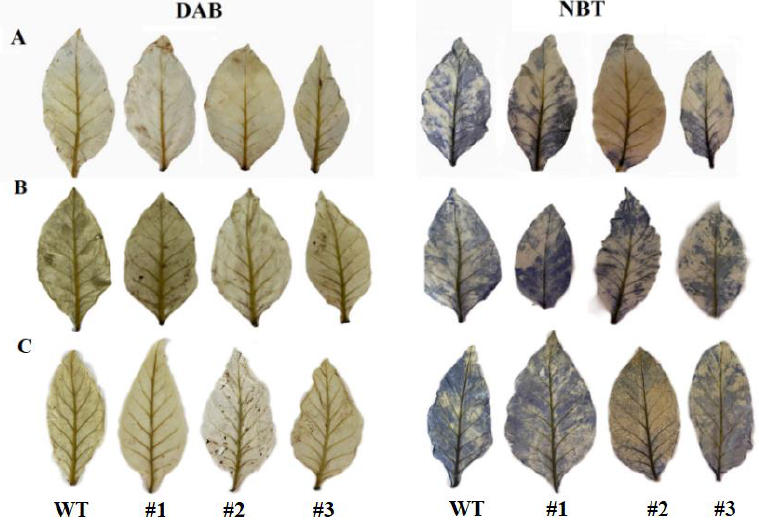
Figure 9. DAB and NBT staining of transgenic plant leaves is shown for plants subjected to cold treatments of ( A ) 4 °C for 2 h; ( B ) 2 °C for 2 h; ( C ) −2 °C for 2 h.